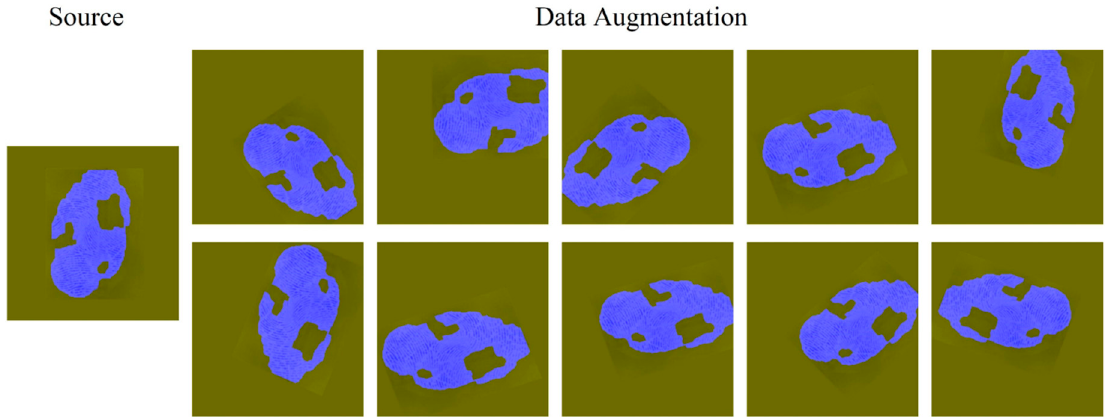
Figure 2. Original fingerprint image and data augmentation.